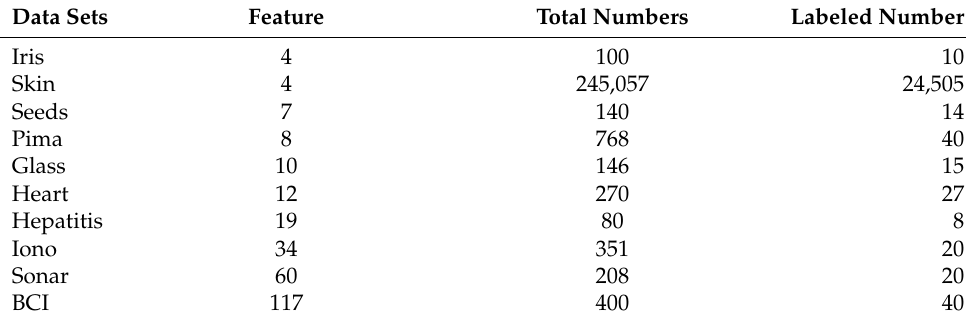
Figure 2. Decision function for the simulated data. Table 1. Details of